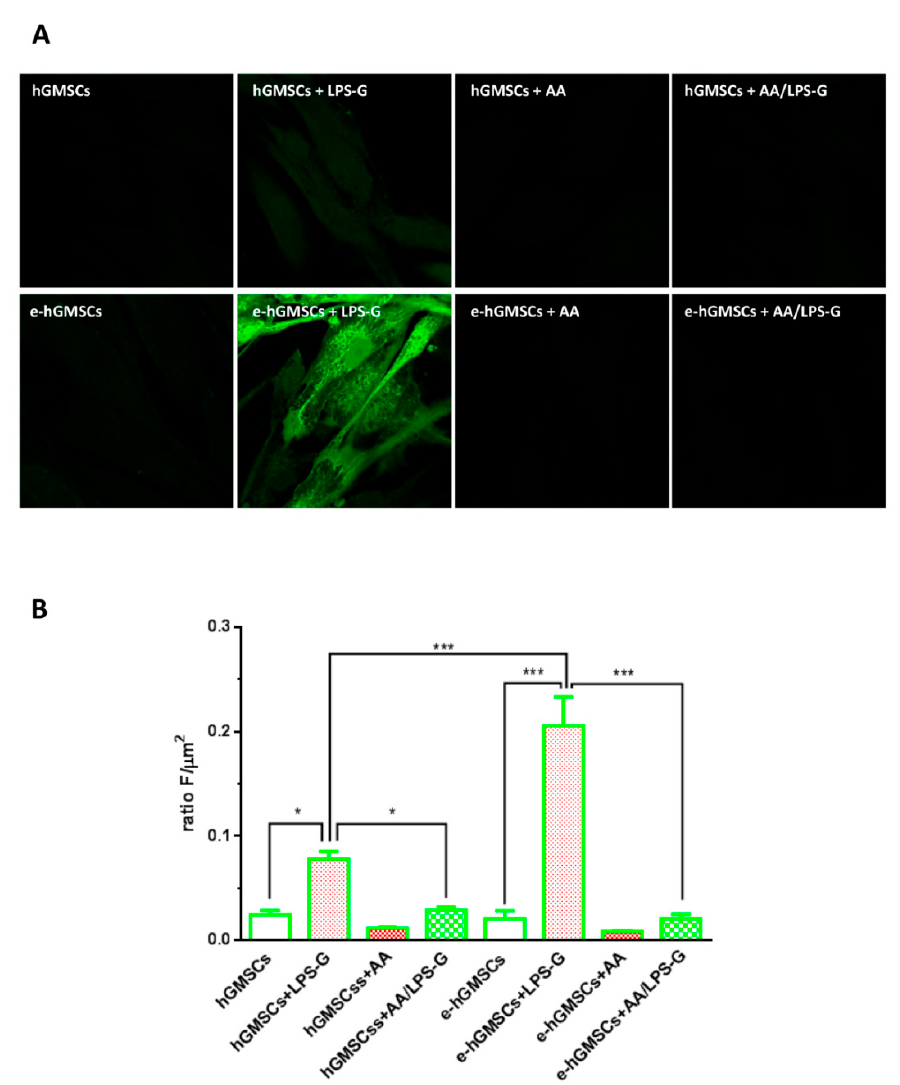
Figure 8. ROS measurements. ( A ) Representative images of H2DCFDA-loaded cells. ( B ) Analysis of ROS production calculated as arbitrary unit of fluorescence per cell surface unit (F/ µ m2). Data are expressed as mean ± S.E.M (hGMSCs n = 166, hGMSCs + LPS-G n = 148, hGMSCs + AA n = 100; hGMSCs + AA/LPS-G n = 176; e-hGMSCs n = 85, e-hGMSCs + LPS-G n = 195, e-hGMSCs + AA n = 159; e-hGMSCs + AA/LPS-G n = 125, for each experimental condition n = 3). * p < 0.05; *** p < 0.001. Statistical analysis was performed by one-way ANOVA and post hoc Bonferroni. Scale bar: 20 μ m.